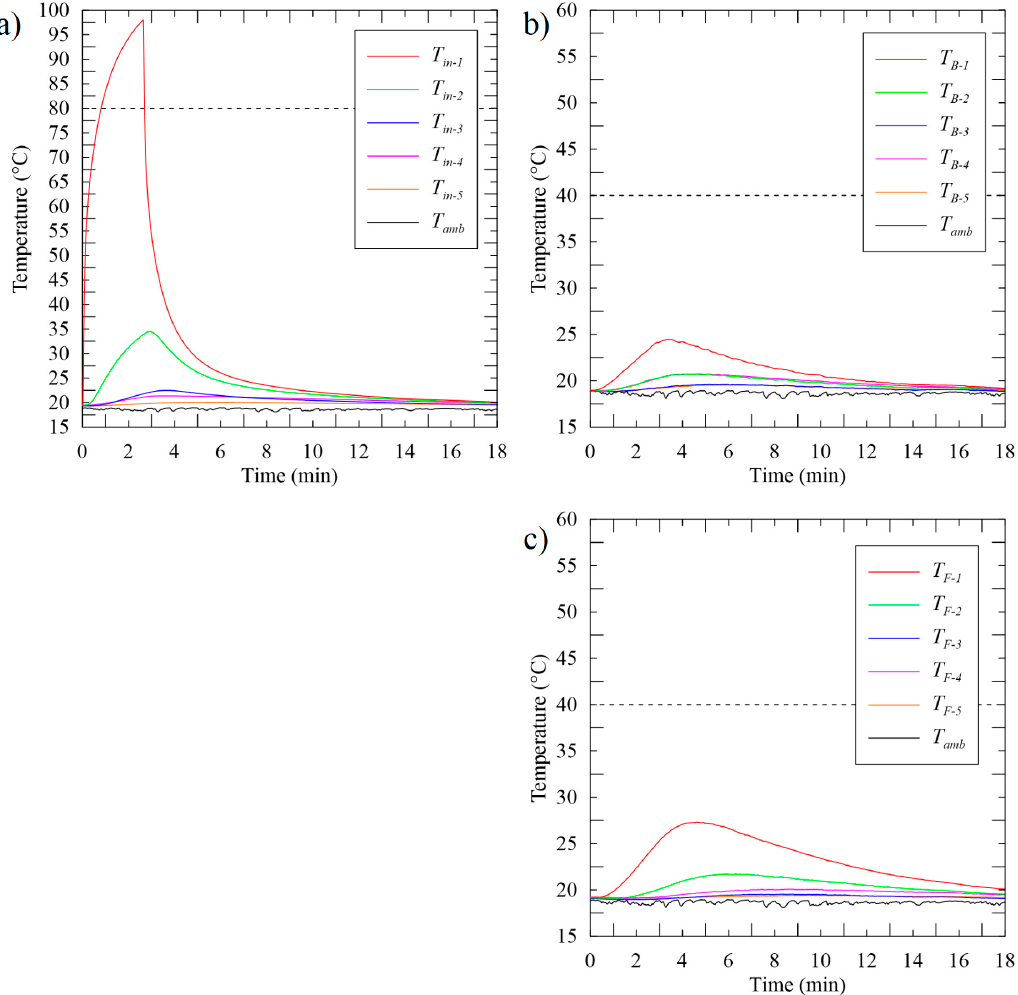
Figure 9. Temperature measurements on the ( a ) inside, ( b ) back cover, and ( c ) display of the mock tablet with an aluminum heat spreader installed and a heat generation rate of 7 W (the dashed line represents the relevant temperature limit). Figure 10 shows the same experiment with added TIM. With the higher heat generation rate of 7 W, the impact of the TIM is essential to managing the temperature of the mock tablet. Without the TIM, the mock tablet overheats at the heater in 0.8 min. With TIM included, the mock tablet overheats at the front cover after 14.7 min, while the SoC barely reaches its maximum allowed temperature of 80 °C at the very end of the heating phase.